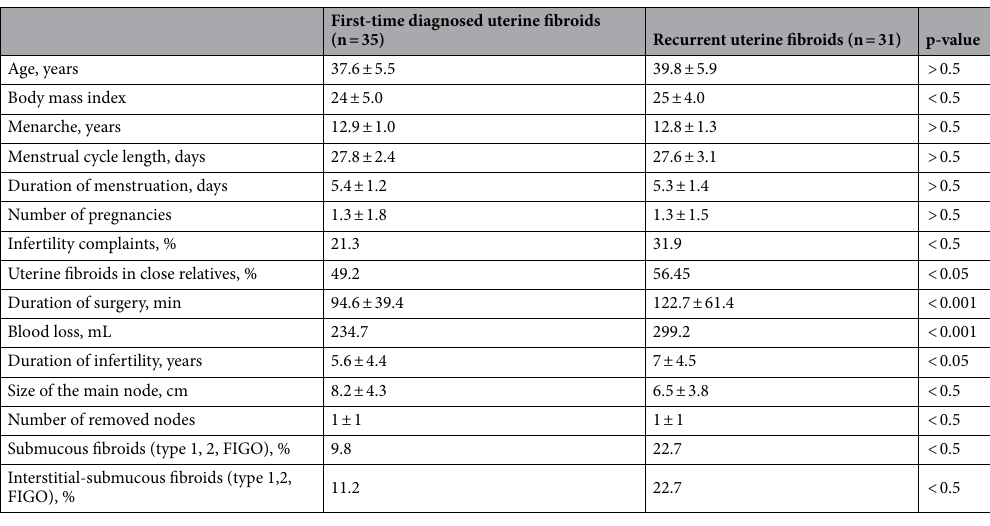
Table 1. Clinical and demographical data for UF and RUF